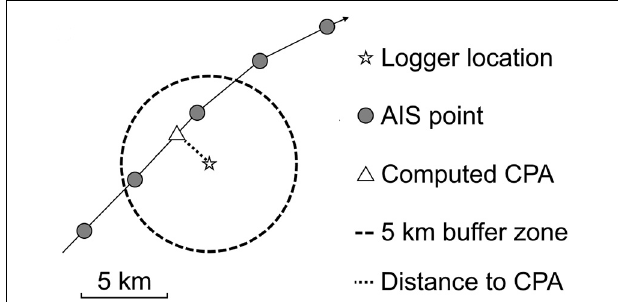
FIGURE 3 | Illustration of determining the location of CPA along the trajectory between two AIS points closest to the hydrophone